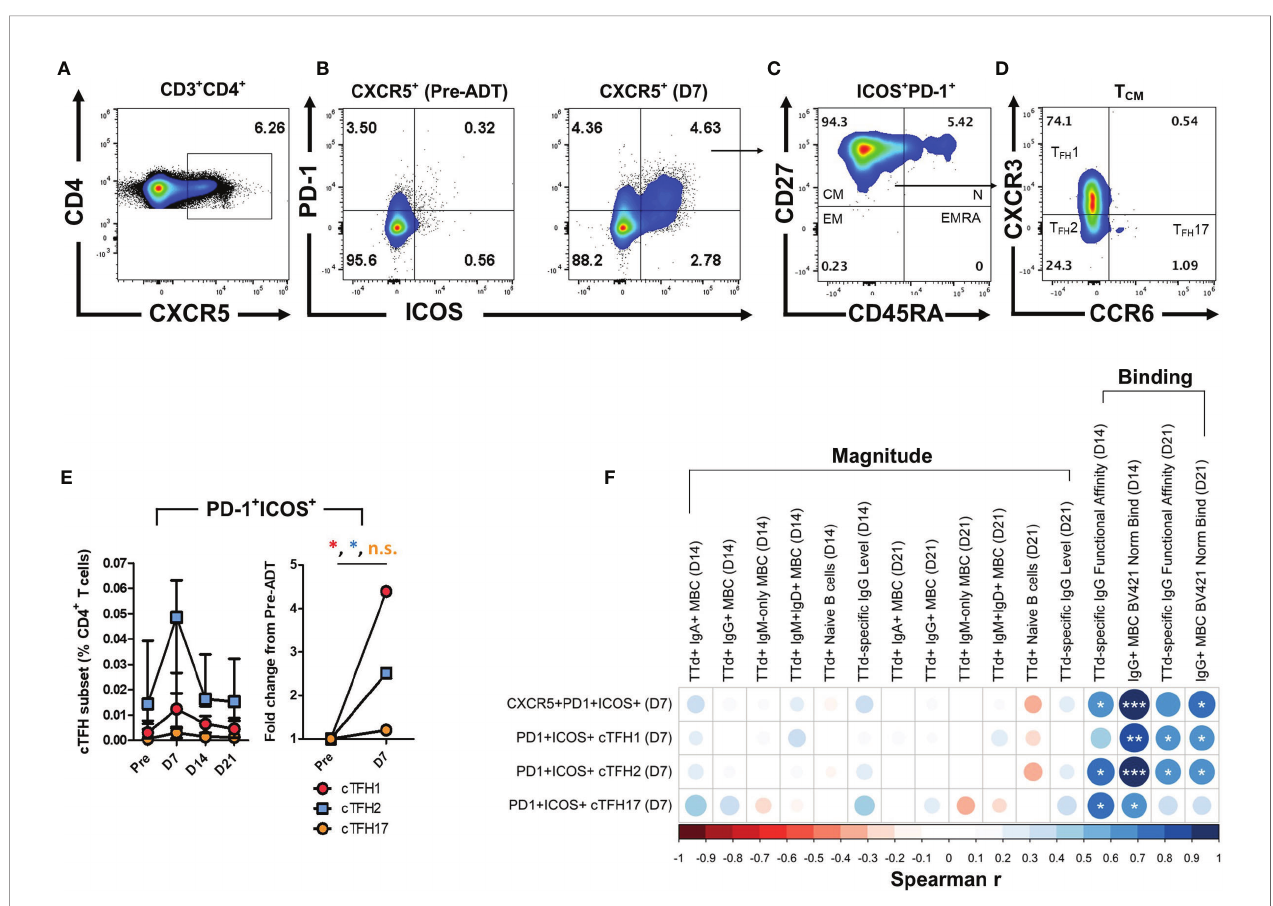
FIGURE 6 | Identi fi cation of activated cT FH cells with type 1, 2 and 17 helper T cell phenotypes after booster ADT vaccination and the relationship of day 7 cT FH cell subset frequencies with day 14 and day 21 TTd + B cells and plasma IgG Abs. (A) cT FH cells were identi fi ed in the CD3 + CD4 + T cell population as CXCR5 + cells. (B) Within the CXCR5 + cT FH cell population, a quadrant gate was applied to identify PD-1 + ICOS + cT FH cell. Representative plots show an expanded PD-1 + ICOS + cT FH cell population at day 7. (C) Within PD-1 + ICOS + cT FH , cells that exhibited a central memory phenotype (TCM; CD27 + CD45RA - ) were further gated. (D) Finally, differential CXCR3 and CCR6 expression was used to de fi ne the cT FH 1 (CXCR3 + CCR6 - ), cT FH 2 (CXCR3 - CCR6 - ) and cT FH 17 (CXCR3 - CCR6 + ) phenotypes. (E) Median (IQR) frequencies (%CD4 + T cells) and fold-change of PD-1 + ICOS + cT FH 1, cT FH 2 and cT FH 17 cells following vaccination. (F) A Spearman ’ s correlation matrix was created to compare frequencies of day 7 PD-1 + ICOS + cT FH subsets (% of CD4 + ) with the ‘ magnitude ’ [subset frequencies (events) or Ab levels (AU/ml)] or ‘ binding ’ parameters (CD79b-normalised TTd binding or plasma IgG TTd + Ab FAI) of t-SNE de fi ned B cell subsets and IgG Abs at days 14 and 21 post-ADT vaccination. *, ** and *** denote p < 0.05, 0.005 and 0.0005, respectively. n.s., not signi fi